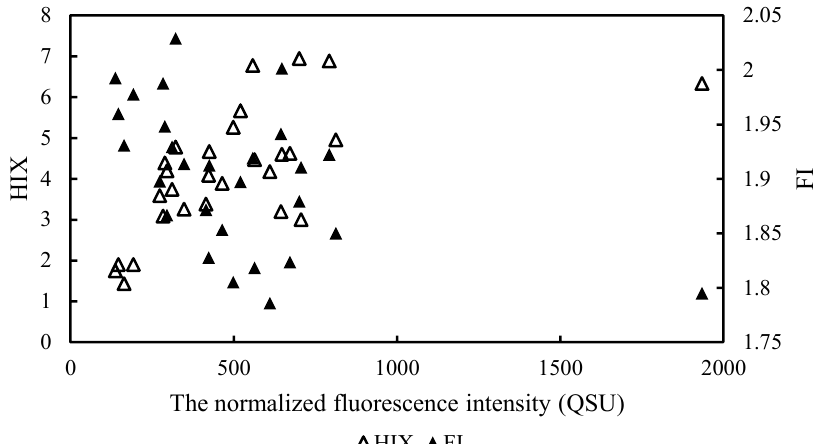
Figure 5. Humification indices and fluorescence indices versus the total normalized fluorescence intensity in grassland water regime.